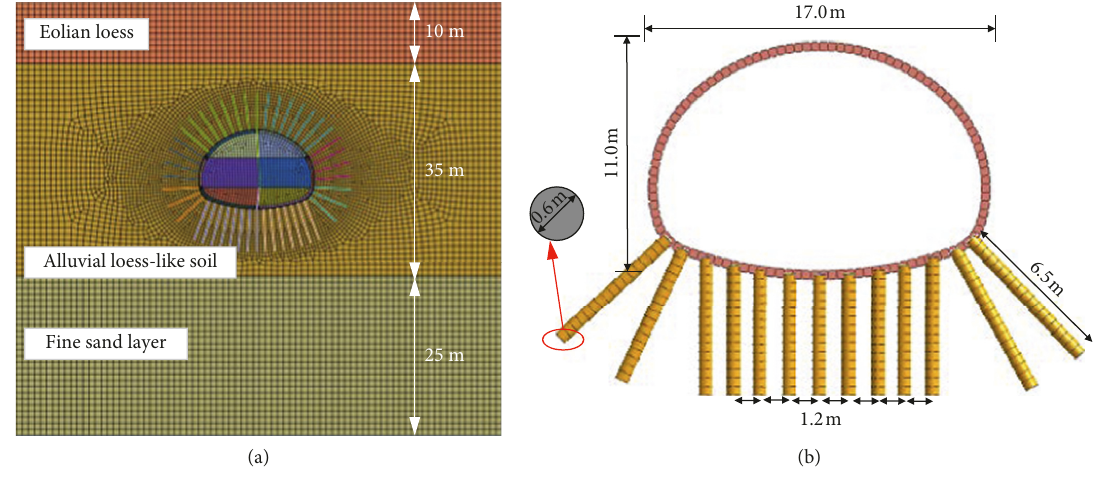
Figure 2: Mesh model and jet grouting pile